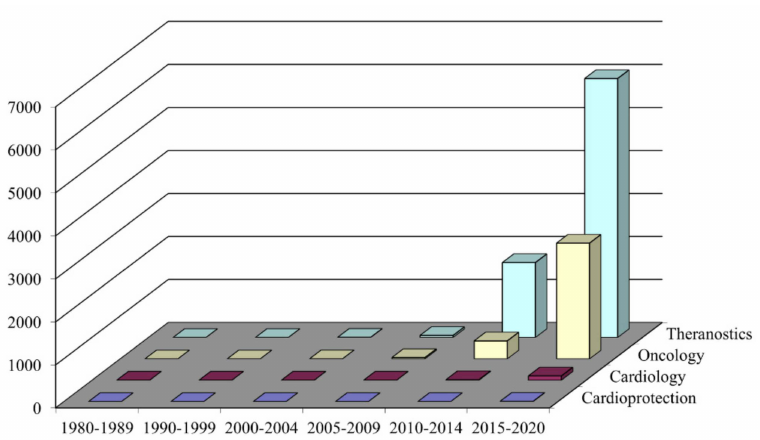
Figure 2. Dynamics of publications, using the PubMed database from 1980 to